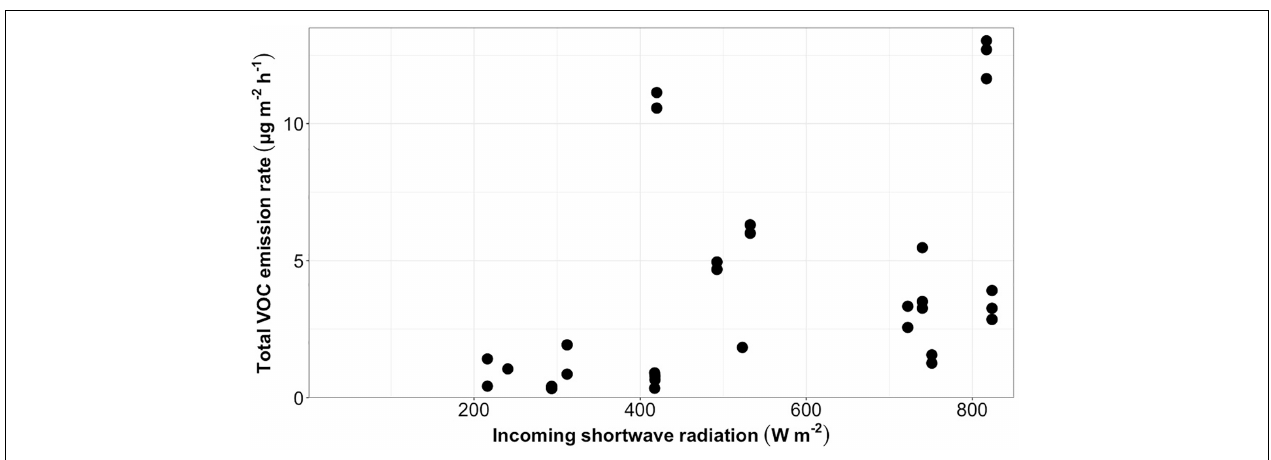
FIGURE 2 | Total VOC emission rates ( µ g m − 2 h − 1 ) from bare ice surfaces ( n = 31) plotted against average incoming shortwave radiation (W m − 2 ) during sample collection.